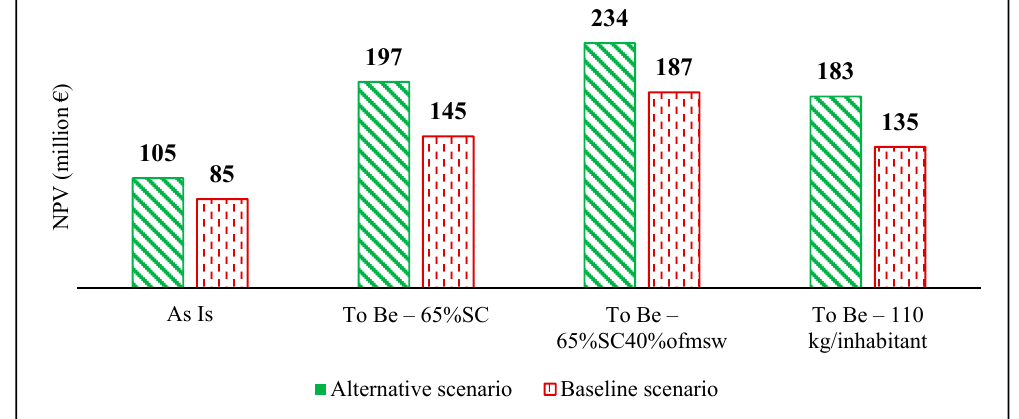
Figure 6. Economic benefits (million € ) in the 15 municipalities from managing the OFMSW—alternative scenario (joint implementation biomethane producer and methane distributor).